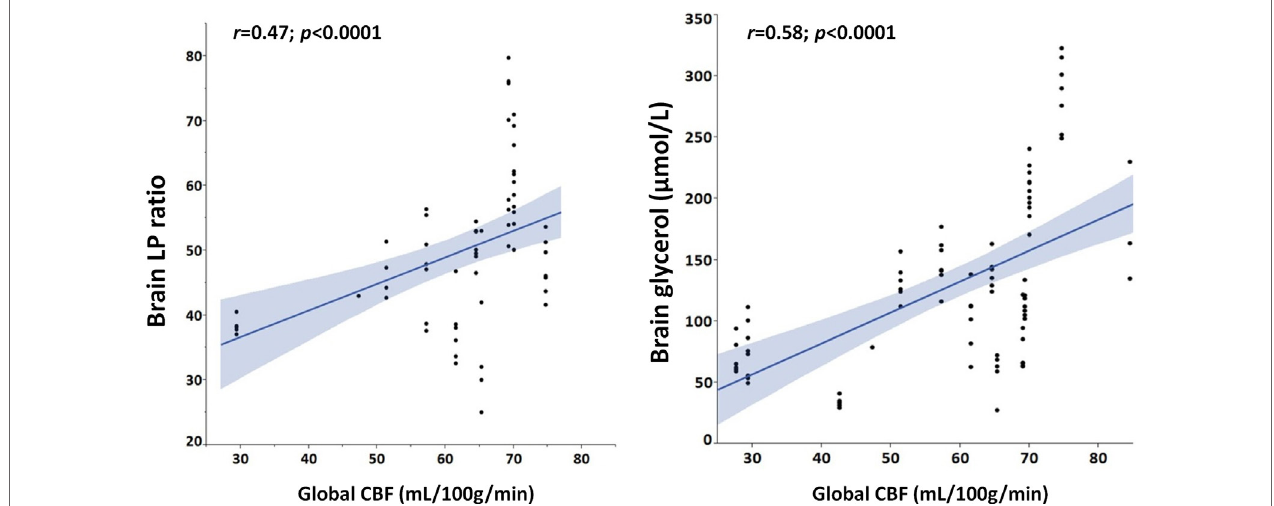
FigUre 2 | Hyperemic cerebral blood flow (CBF) is positively correlated with cerebral metabolic and cellular distress. Graphs illustrate Spearman’s linear correlations of global CBF, measured with perfusion CT, with brain extracellular concentrations of lactate/pyruvate (LP) ratio and